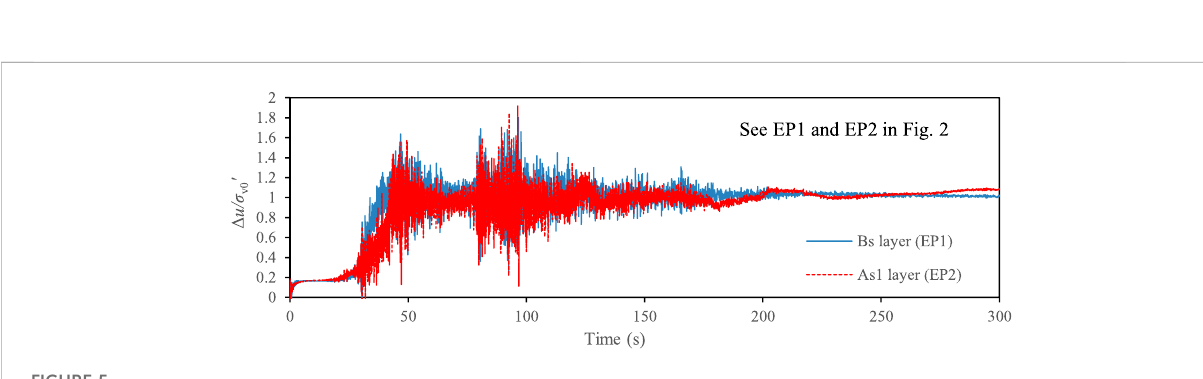
FIGURE 5 Time histories of the excess pore water pressure ratio at two typical points (see EP1 and EP2 in Figure 2).